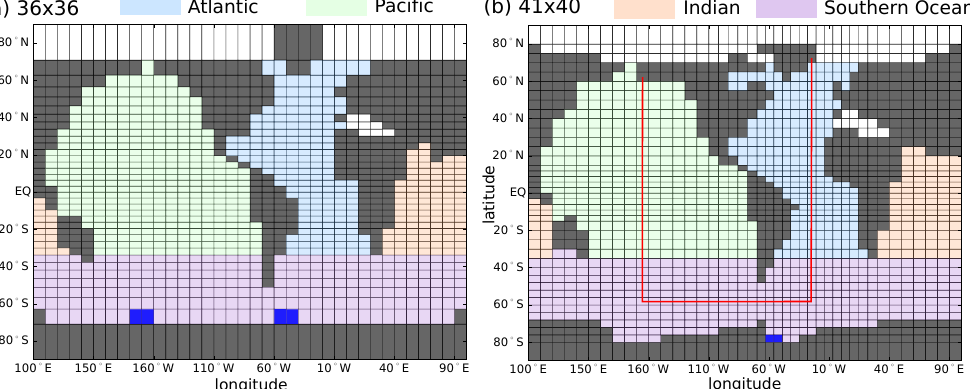
Figure A2. Comparison of the horizontal grid for the previous (36 × 36) (a) and updated (41 × 40) (b) versions of the Bern3D ocean model. Both versions feature 32 depth layers. Latitudinal resolution near the Equator remained largely unchanged, while resolution was increased at the high latitudes. The ocean, atmosphere and sediment models share the same horizontal grid. The red line in (b) shows the path of the transect plot used in the main text. The light colours depict the definition of ocean basins as used to calculate depth gradients and zonal